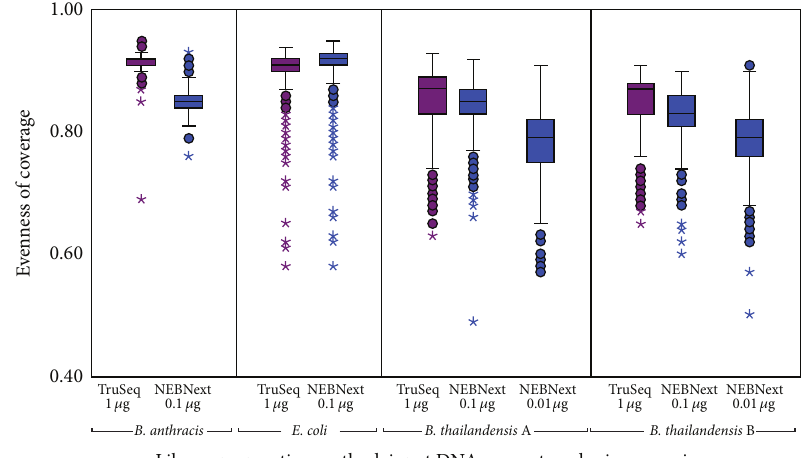
Figure 3: Box and whisker plots of the variation of coverage when mapping reads to the reference genomes. Variation was calculated for nonoverlapping 10kbp windows. Evenness of coverage is calculated as 1 − (standard deviation of coverage/median